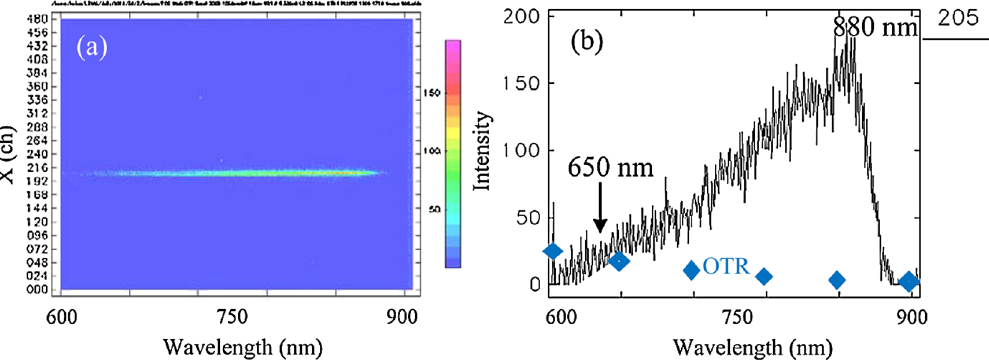
FIG. 12. (Color) COTR spectrum with NIR MCP utilized showing (a) x - (cid:2) image and (b) profile through the localized x enhancement. The entrance slit was narrowed to give few-nm resolution with a 95 lines per mm grating. In addition, an incoherent OTR broadband spectrum is indicated by the blue